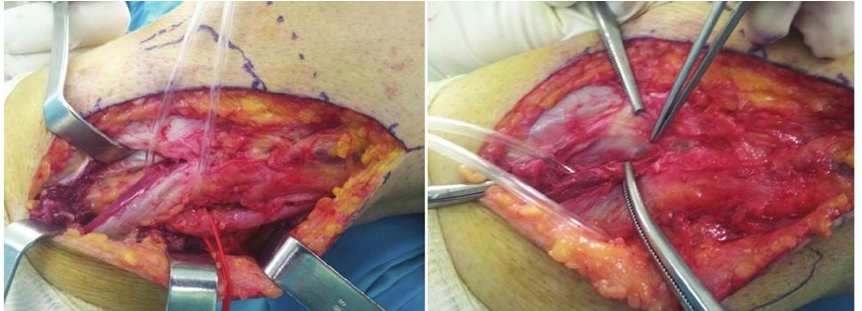
Figure 2: Left knee lateral approach. The CPN and its branches were recognized and traced to its bifurcation. The ganglion mass was followed down to its stalk and removed